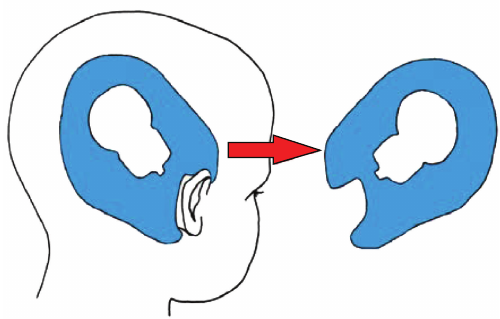
Figure 3: Drawing of a paper blueprint of the position of the implant relative to the ear in order to determine the correct, symmetrical position of the contralateral implant in bilateral im- plantation. The position of the implant at the first operated ear is marked on a paper sheet and transposed on to the contralateral side.